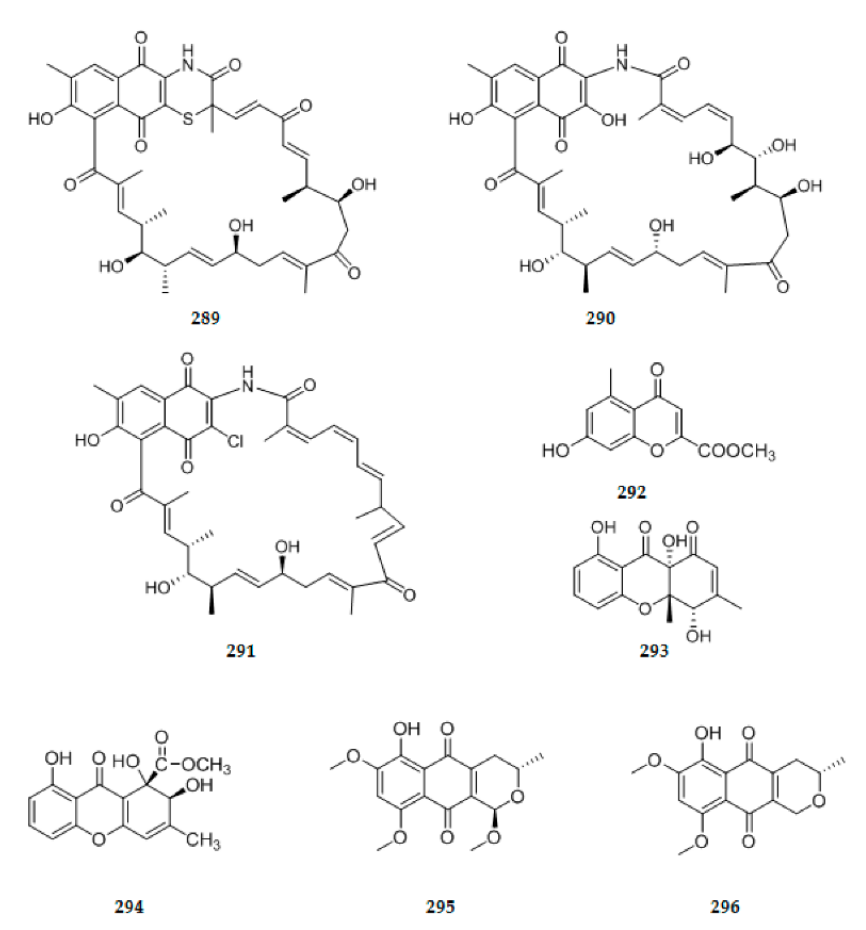
Figure 10. Chemical structures of anthraquinones.